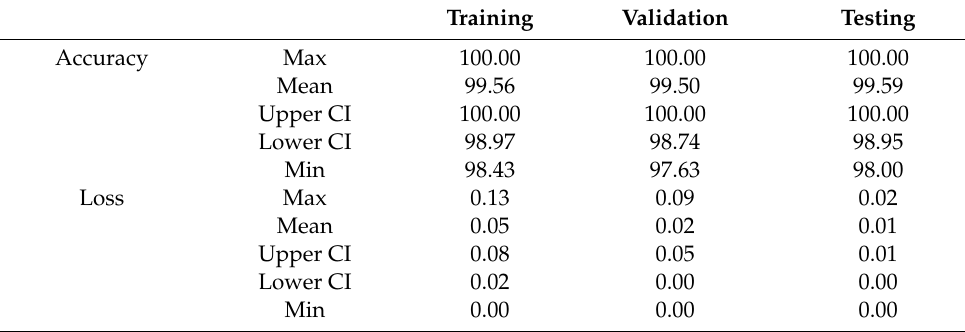
Table 2. Performance accuracy and loss of training, validation, and testing of Neural Network after 30 iterations. All accuracy values are presented in